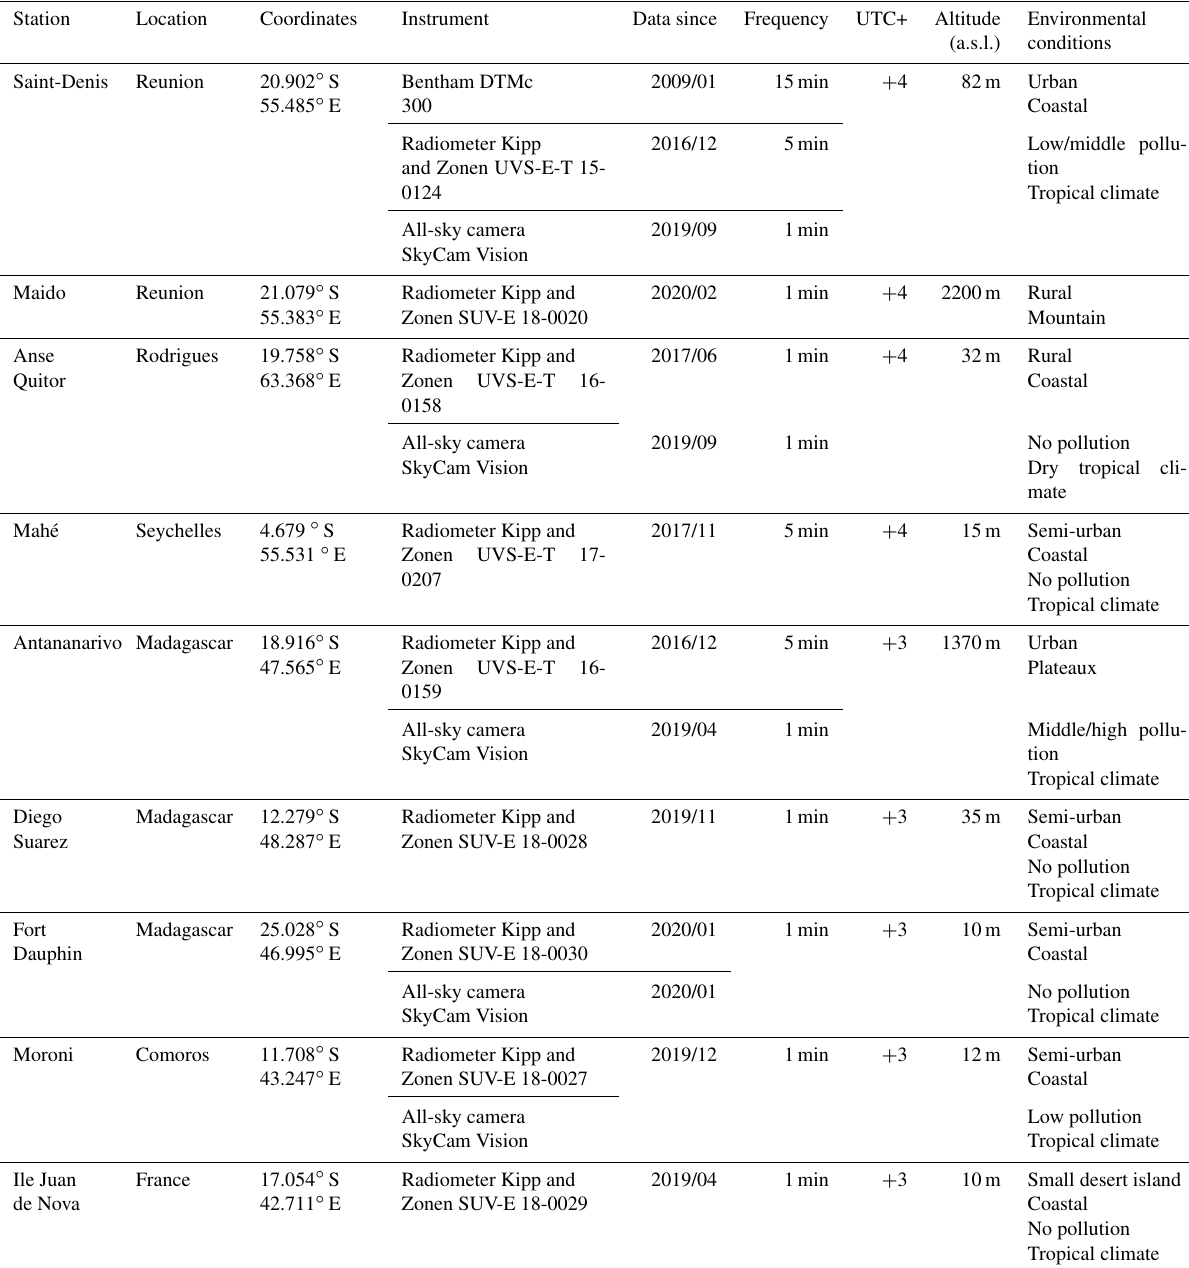
Table 1. Stations of the UV-Indien project. Date format is year/month.